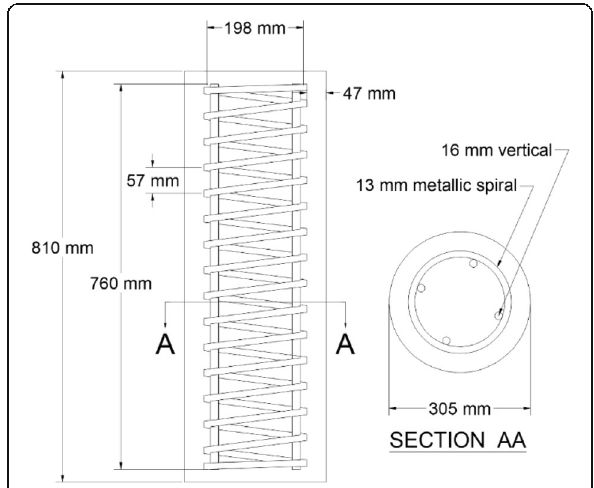
Fig. 1 Concrete column specimen dimensions and